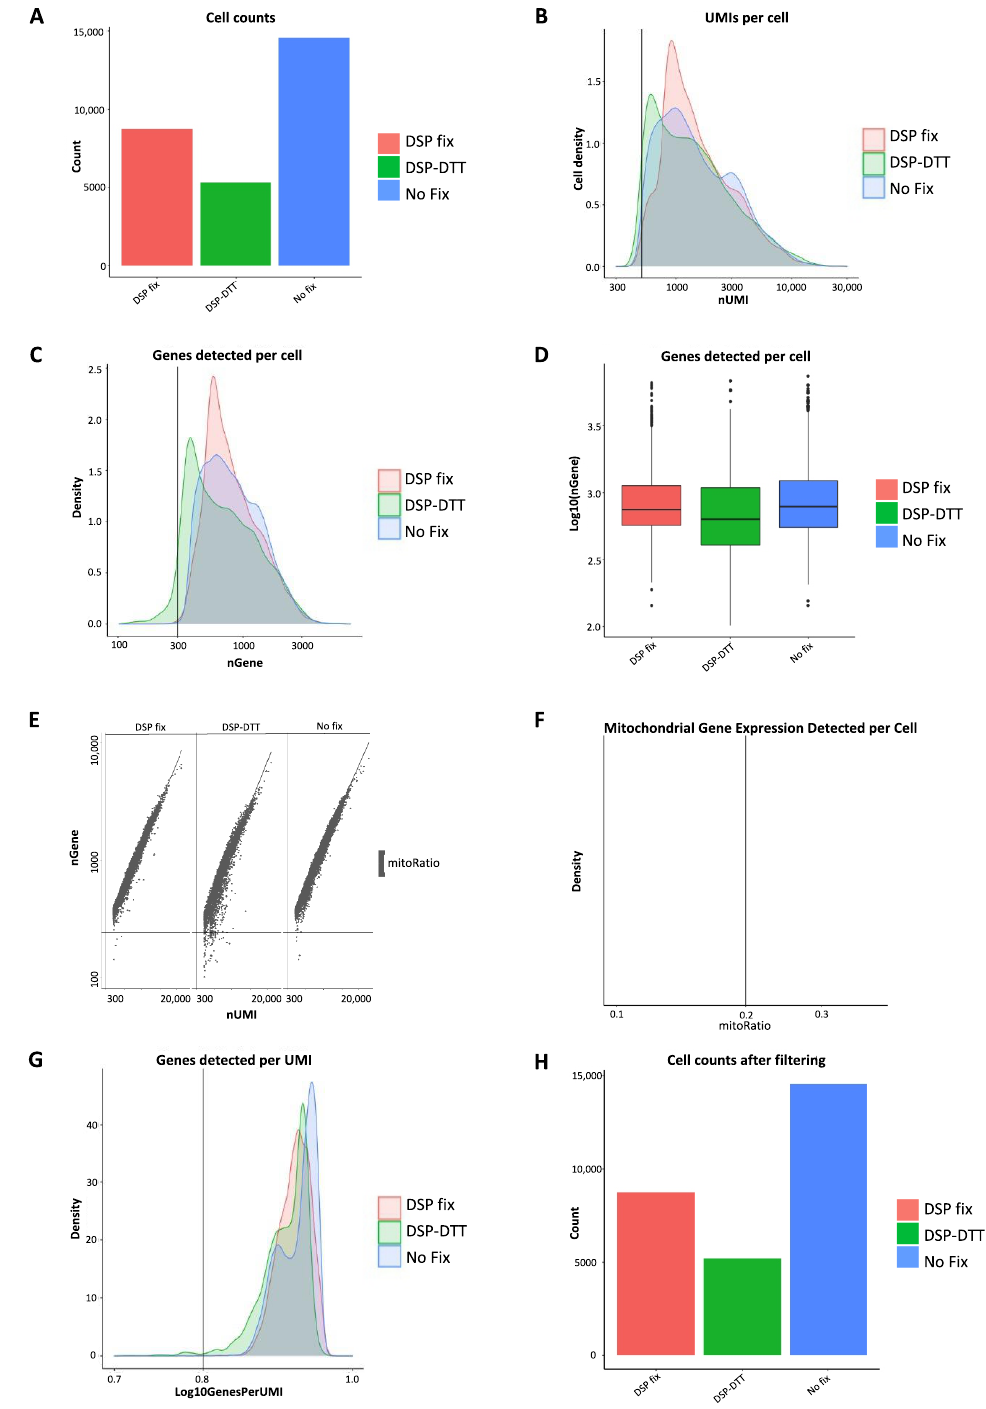
Figure 5. QC of 10 × genomics scRNA-seq data. The estimated number of cells in each sample was calculated using the number of unique cellular barcodes detected ( A ). UMIs (transcripts) detected per cell in each sample. The minimum threshold was set at 500 ( B ). Histogram plot of ratio of genes detected per cell density. The minimum cut-off was set to 300 ( C ). Boxplot of average genes detected per cell ( D ). Correlation between genes detected and number of UMIs for each sample ( E ). Visualization of mitochondrial counts detected per cell. Maximum threshold = 0.2 ( F ). Complexity of each test sample, measured in genes detected per UMI with a minimum score > 0.8 ( G ). Filtered cell counts adjusted for all thresholds ( H